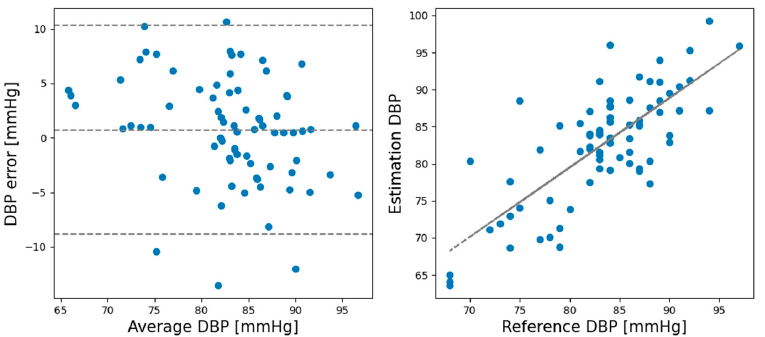
Figure 8. Bland–Altman plots for DBP estimations made by the CNN model in the recovery session.